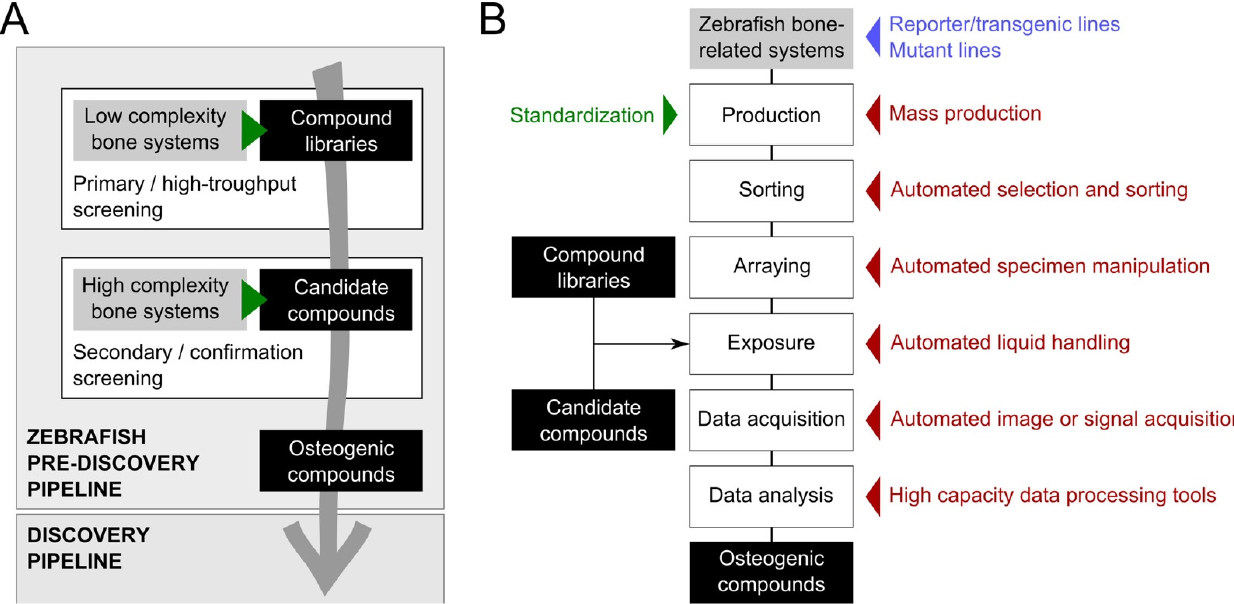
Figure 2. Zebrafish pre-discovery pipeline ( A ) and technological innovation applied to the stand- ardization and automation to improve zebrafish screening throughput and data accuracy ( B